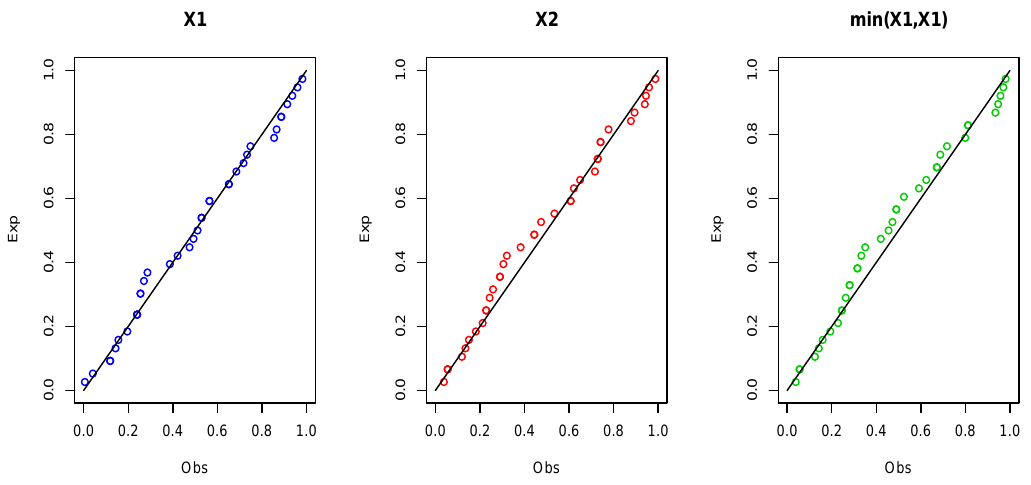
) for data set I. , X and min ( X , X , X 2 and min ( X , X 2 ) for data set I. 2 2 1 1 1 1